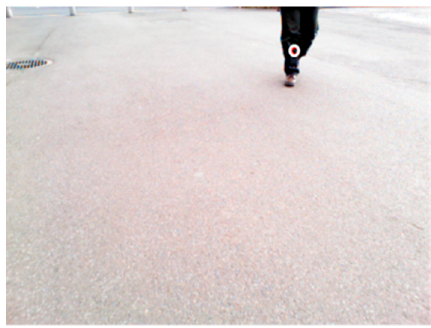
Figure 23. An example of dynamic hazardous object detection in daylight.